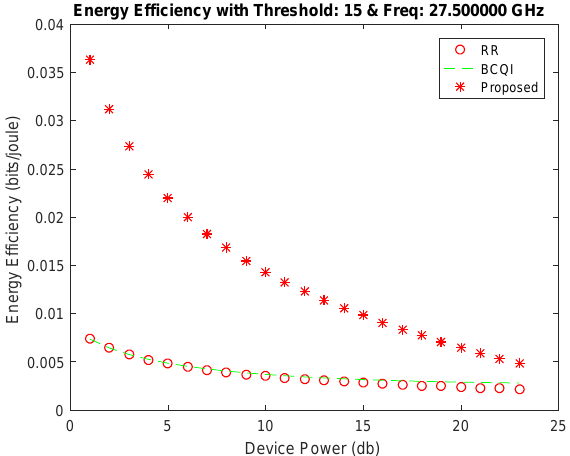
Figure 8. Energy efficiency achieved at threshold 15.